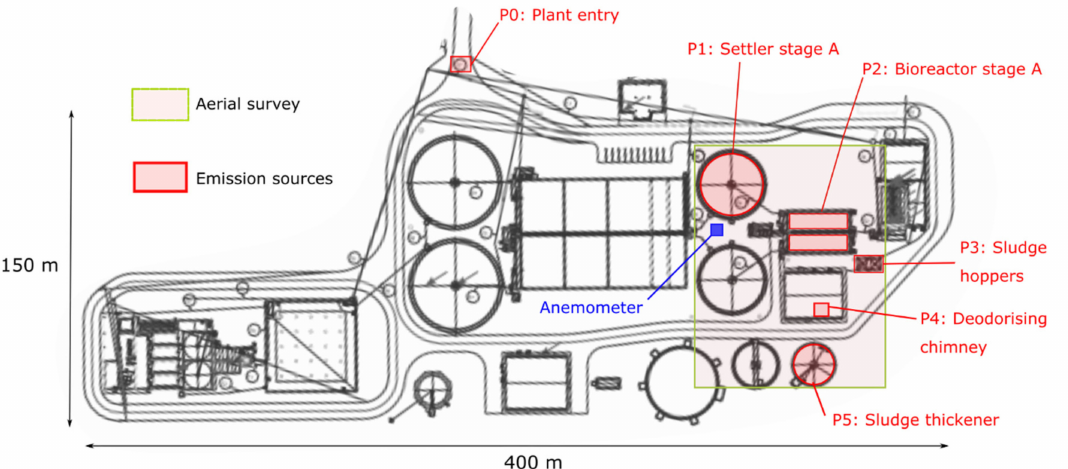
Figure 1. Map of the WWTP of Molina del Segura with the five main emission sources highlighted in red. The aerial mapping was focused on a 4500 m 2 squared region centered around these